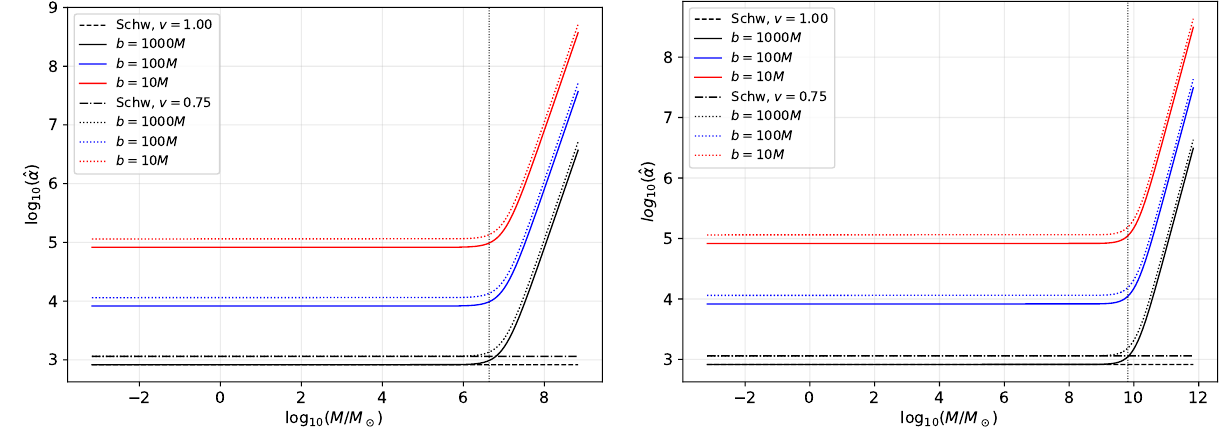
Figure 4. Weak deflection angle by Sgr. A* ( Left ), and M87* ( Right ) for different values of impact parameter. The vertical dotted line is the mass of the black hole considered. See text for details.